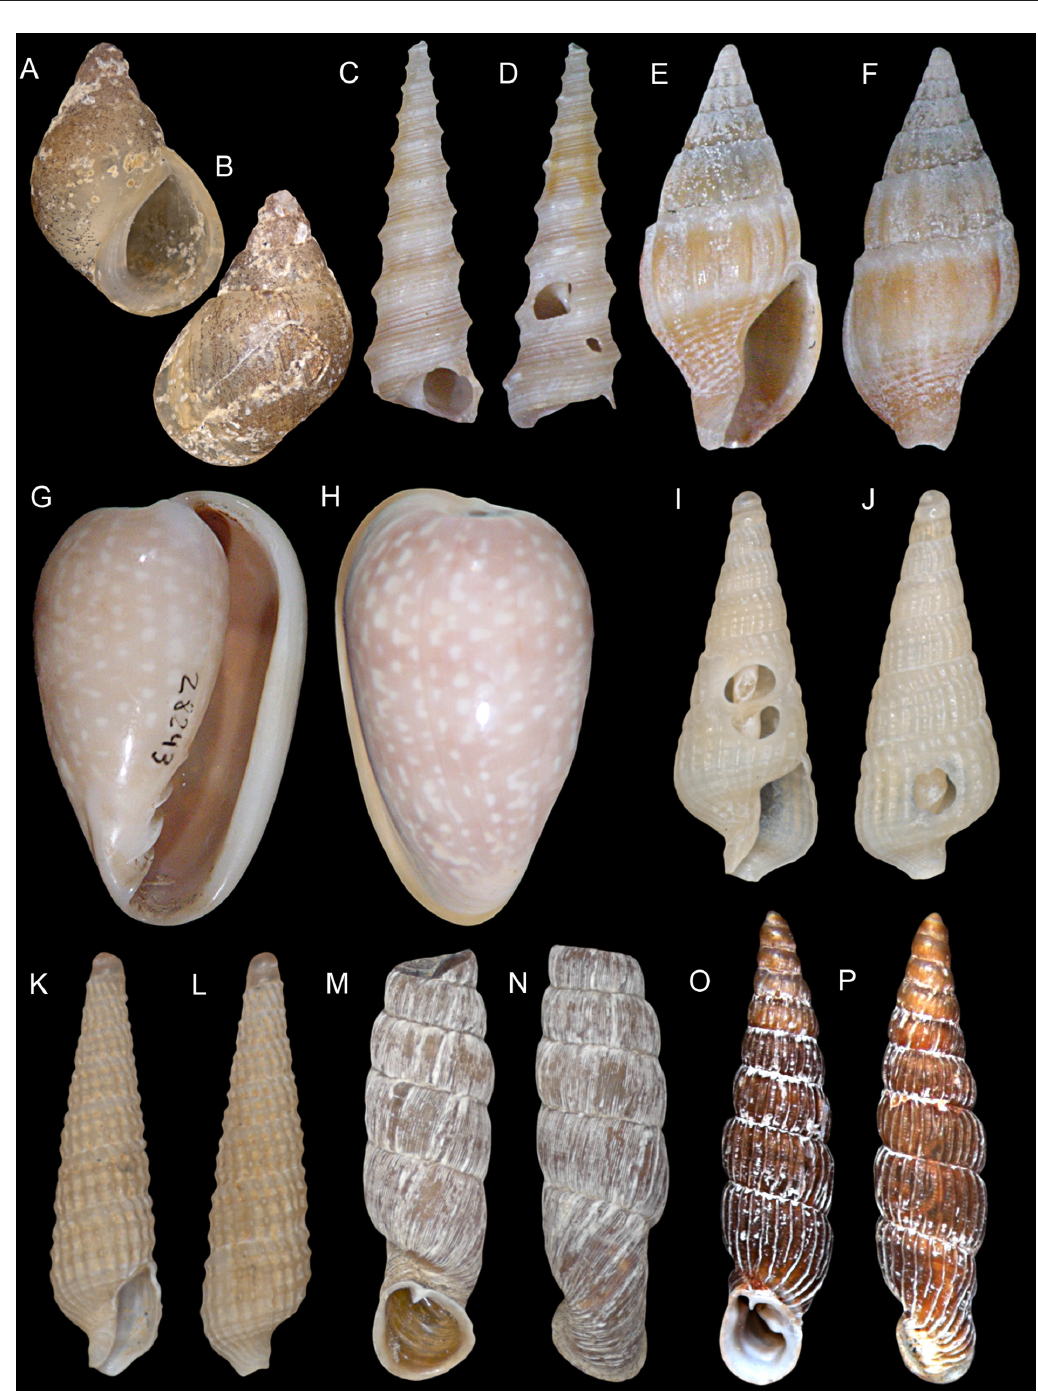
Fig. 5. A–B . Lithoglyphopsis aperta Temcharoen, 1971, Probable paratype MZSP 95942, L = 2.75 mm, W = 2 mm. C–D . Turritella ahiparana Powell, 1927, Probable paratype MZSP 101757, L = 12.7